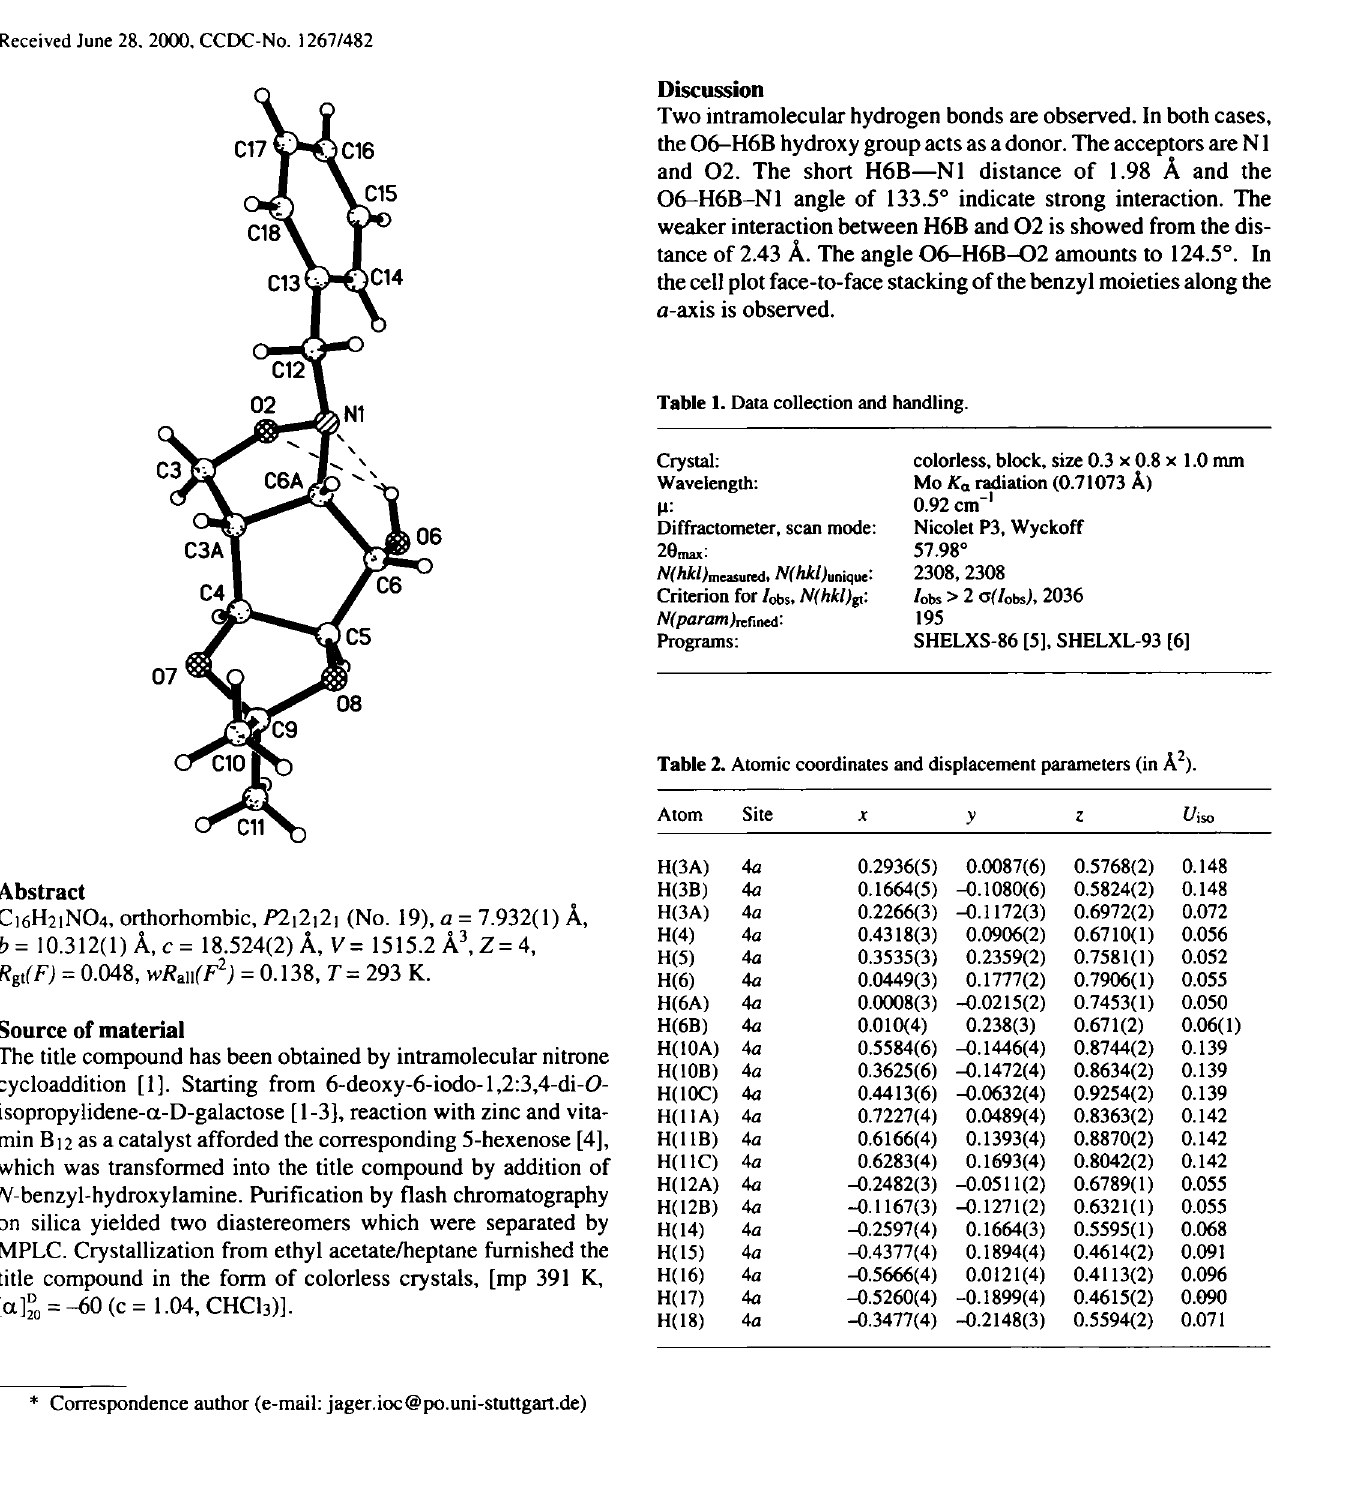
Table 1. Data collection and handling. Crystal: